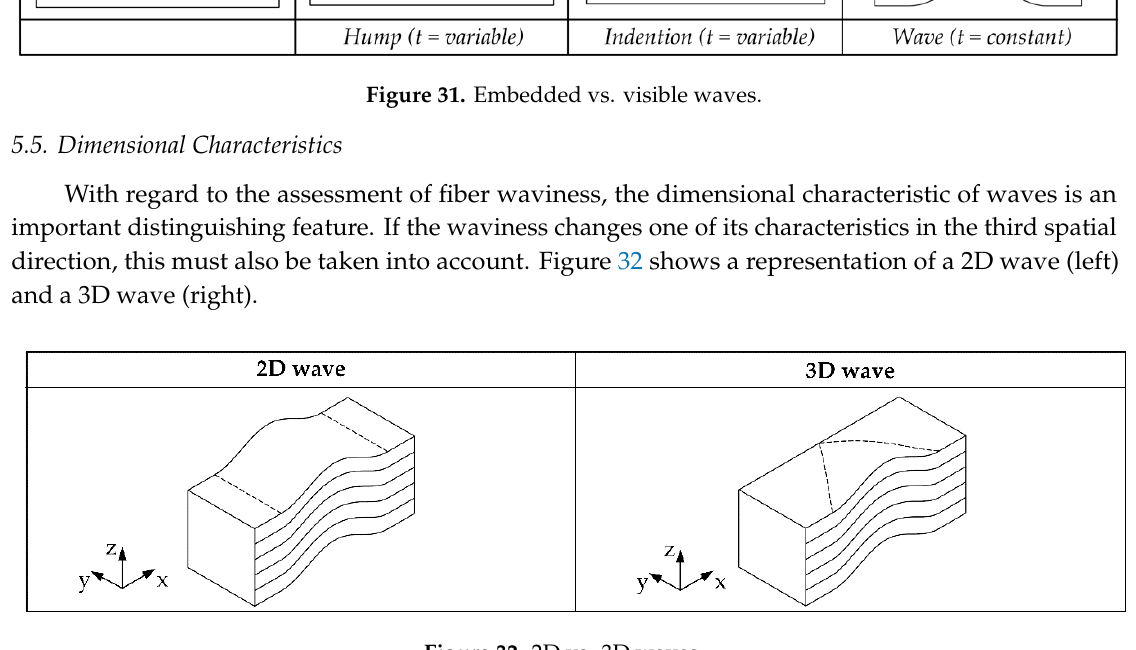
Figure 31. Embedded vs. visible waves.